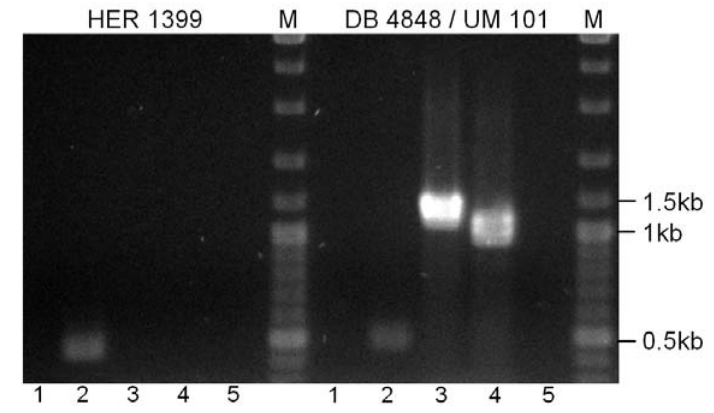
Figure 6. PCR detection of TP21-T. Left block: A colony of HER1399 was used as template. Right block: A colony of DB 4848 / UM 101 was used as template. M: 1kb Marker (Fermentas). 1. Primer combination TP21-L1_Fw and R; 2: Primer combination TP21-L2_Fw and R; 3: Primer combination TP21-T1_Fw and R; 4: Primer combination TP21-T2_Fw and R. 5: Negative control (no